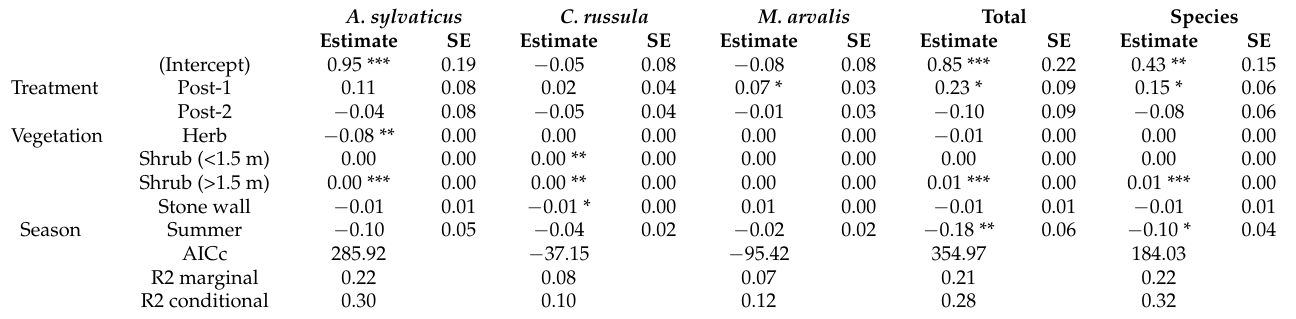
Table 2. Results of the GLMMs performed with the three small mammal species, the total number of individuals, and species density/richness, as response variables, treatment and season as fixed factors, vegetation cover (herbaceous, short and tall shrubs) and distance to stone walls as covariates, and trap as a random factor. AICc values, and variance explained by fixed (marginal) and fixed + random (conditional) factors are shown. For the treatment factor, the pre-treatment (previous) was the reference for statistical